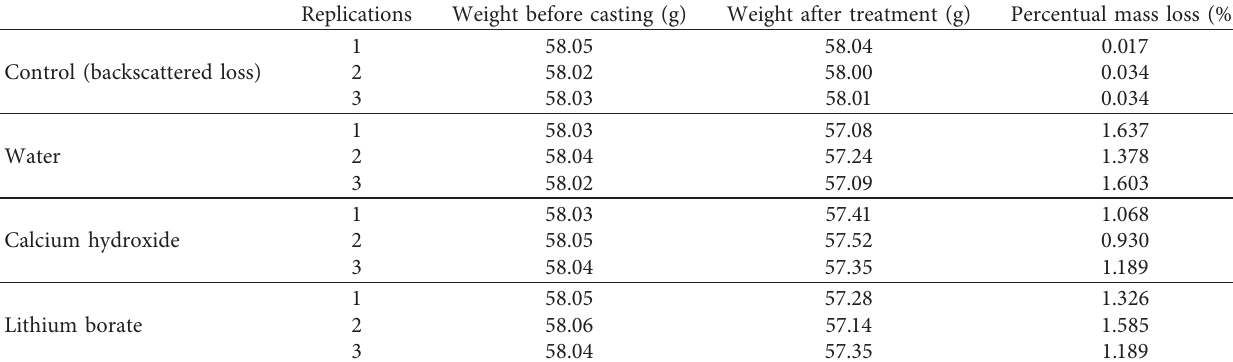
Table 2: Results obtained by weighting the steel bars before and after